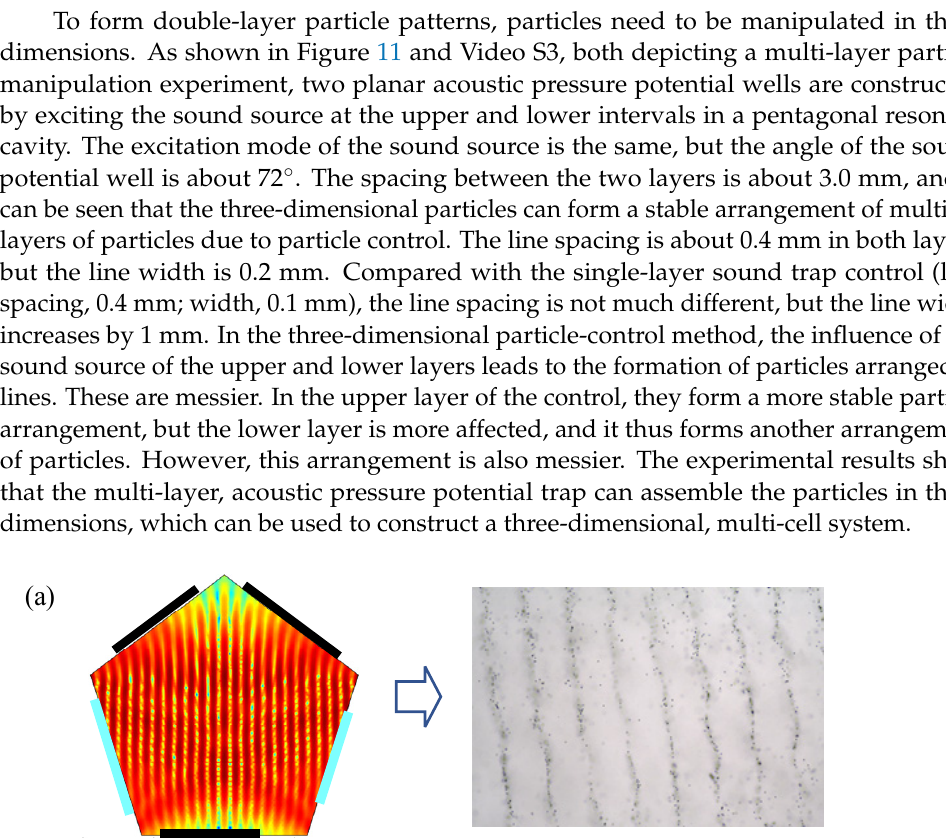
Table 2. Comparison of array spacings between the simulation and experimental results.